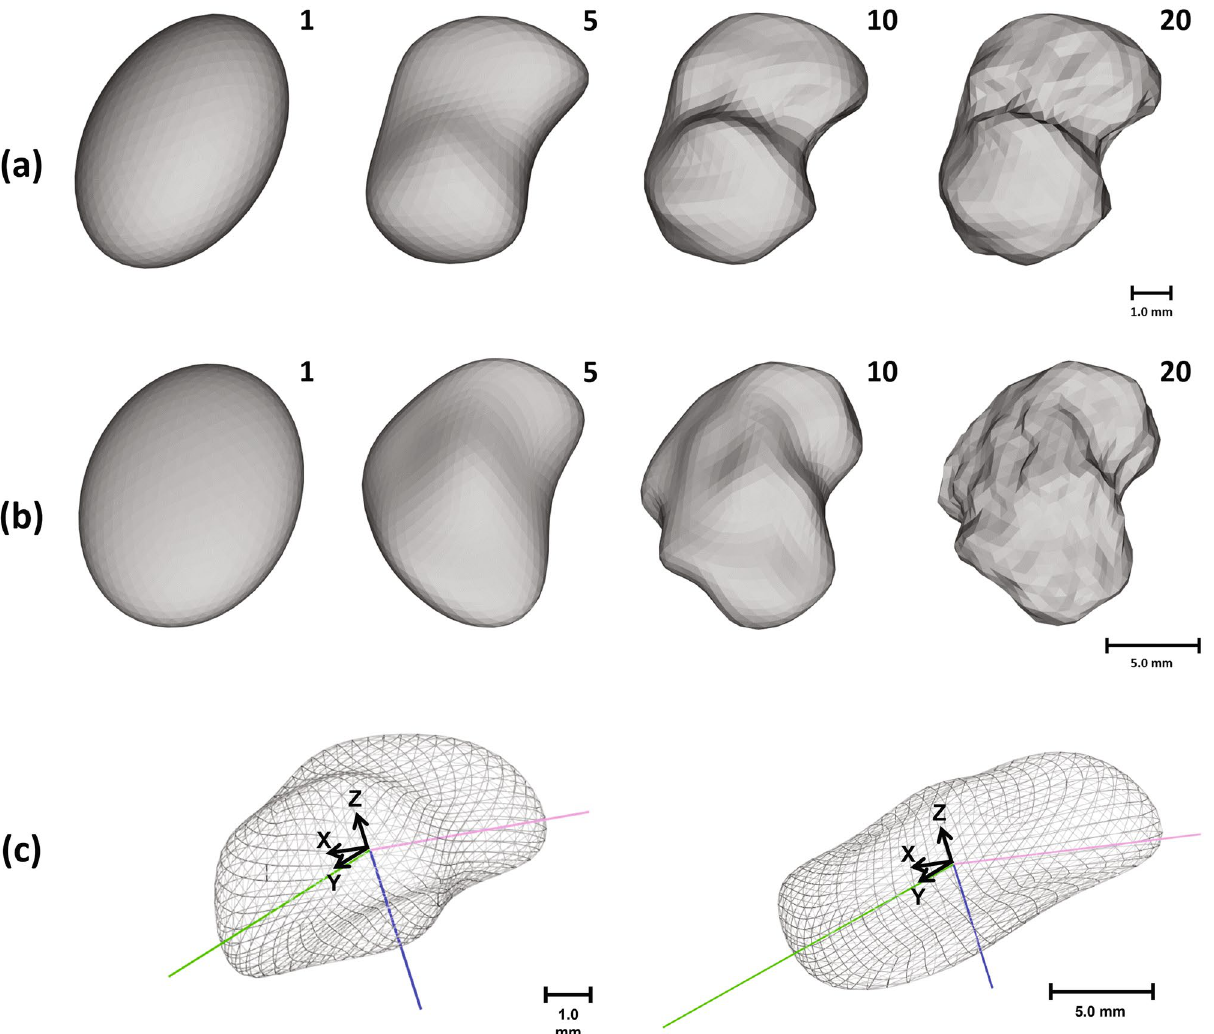
Figure 2. Isometric view of the SPHARM shape description of the proximal left tibial plateau of a typical rat (row a) and rabbit (row b) shown with different numbers of included basis functions of lowest degree (1, 5, 10, 20 harmonics, respectively). In row c, the shape of rat and rabbit tibia, represented by 5 harmonics and aligned towards a common orientation where the smallest principal component (blue) is aligned with the z-axis and the second smallest component (pink) is aligned with the x-axis are